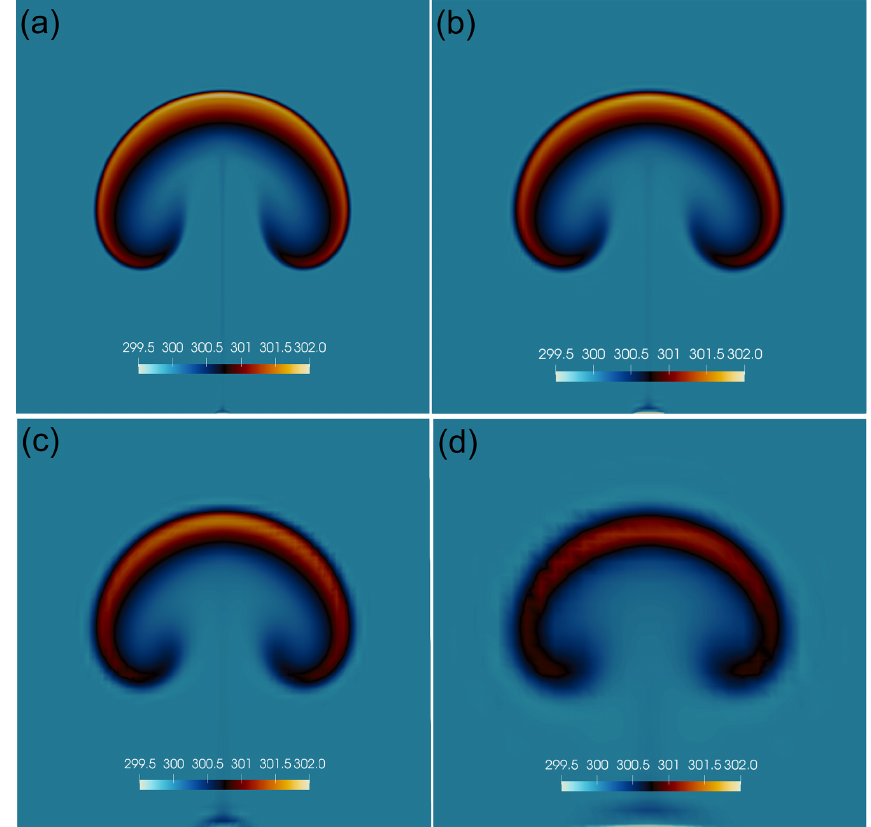
Figure 3. 2 . 5D rising thermal bubble solution with N = 4 at decreasing effective resolution. Grid convergence of potential temperature θ at four different resolutions to be compared against the 15.625m resolution results shown in Fig. 2. (a) (cid:49)x = (cid:49)z = 31 . 25m, (b) 62.5m, (c) 125m, and (d) 250m. Although the solution is visibly more dissipated at coarser resolution, the bubble’s leading edge (and hence propagation speed) is not